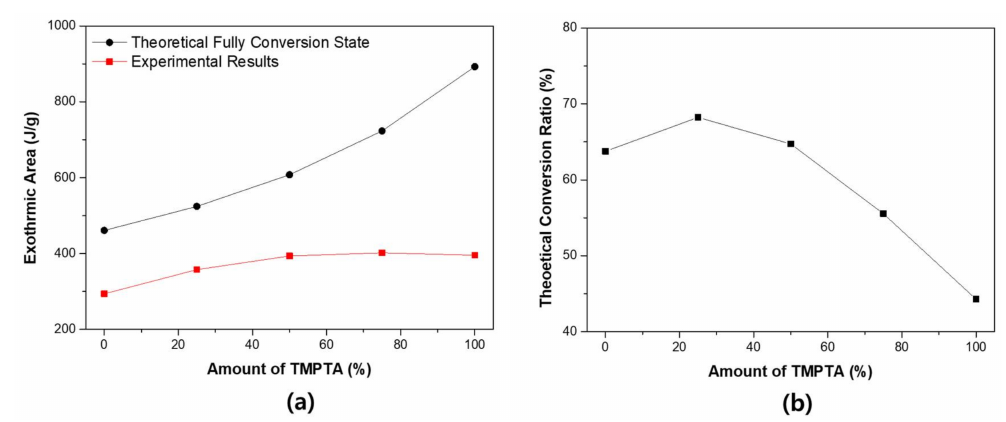
Figure 7. The theoretical double bond conversion ratio of the binary monomer system: ( a ) theoretical/experimental total calorific value (exothermic area); and ( b ) theoretical conversion